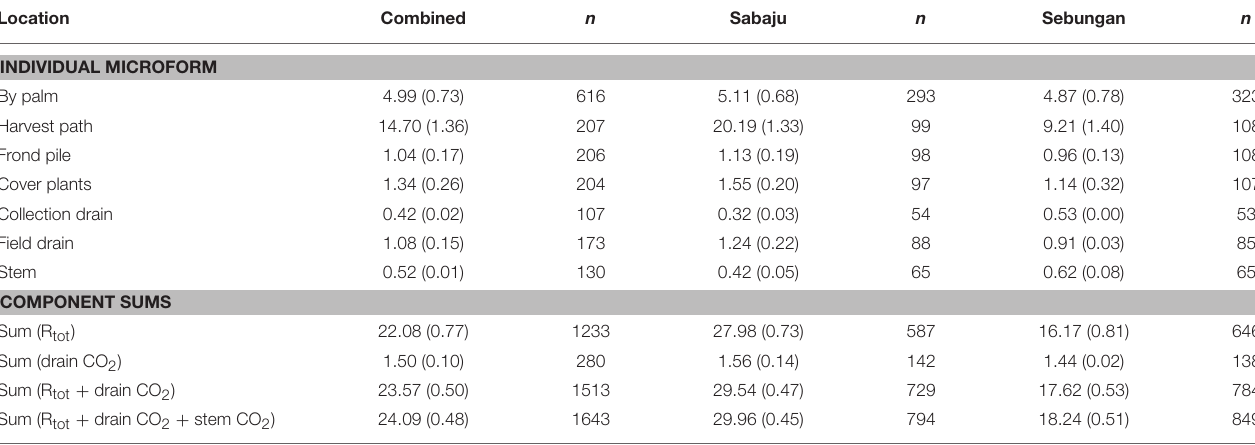
TABLE 3 | Annual upscaled CO 2 fluxes from the different surface microforms sampled at both plantations and at Sabaju and Sebungan individually. Location INDIVIDUAL MICROFORM